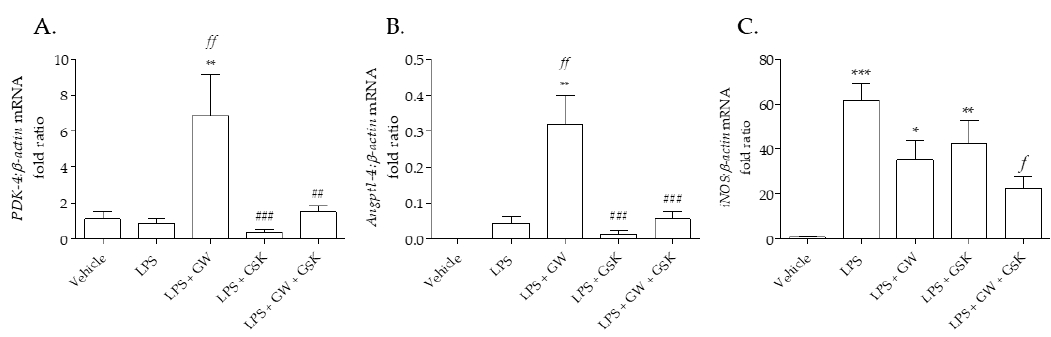
Figure 2. ( A ) PDK − 4 , ( B ) AngPtl4 and ( C ) iNOS mRNA expression in pulmonary arteries following incubation with LPS